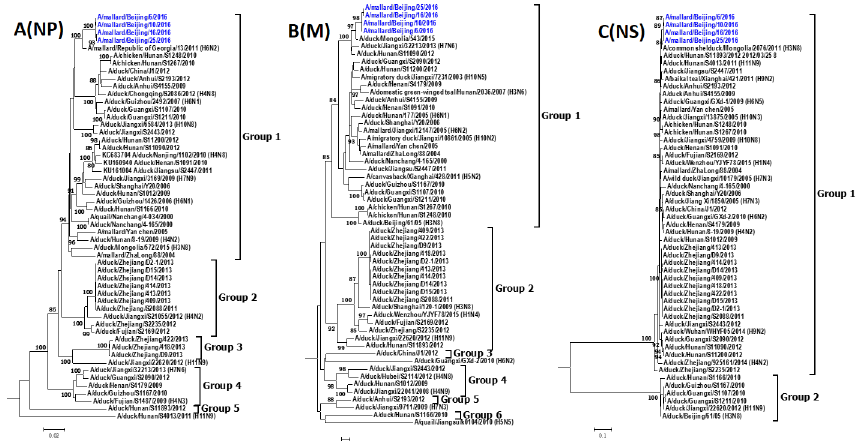
Fig 3. Phylogenetic trees of NP (A), M (B), and NS (C) genes of H4N6 AIVs in China. Phylogenetictrees were generatedby the neighbor-joiningmethod and bootstrapped with 1000 replicates using MEGA6. Analysis was basedon nucleotides1–1497of the NP gene, 1–982 of the M gene, and 1–838of the NS gene. Virus subtypesthat are not H4N6 are indicatedin brackets. Virus strains isolated in this study are highlighted in red.